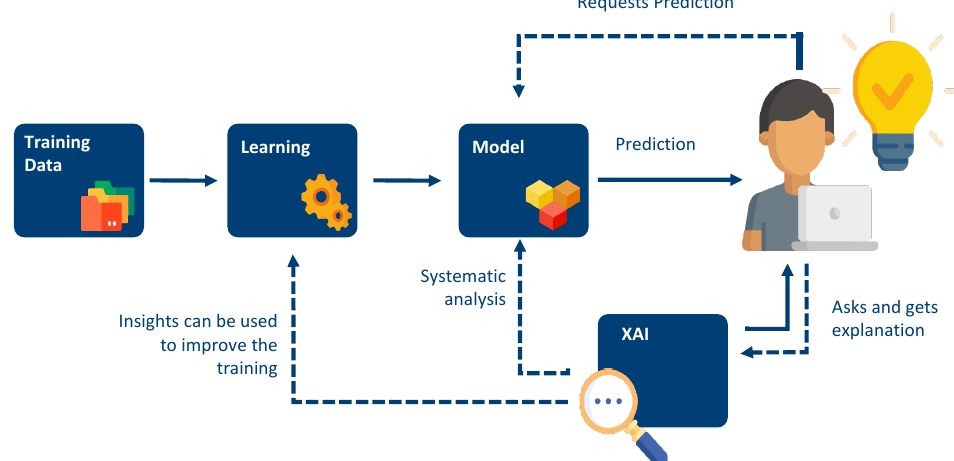
Figure 2. Process of machine learning based prediction with an additional XAI component to explain the results to the